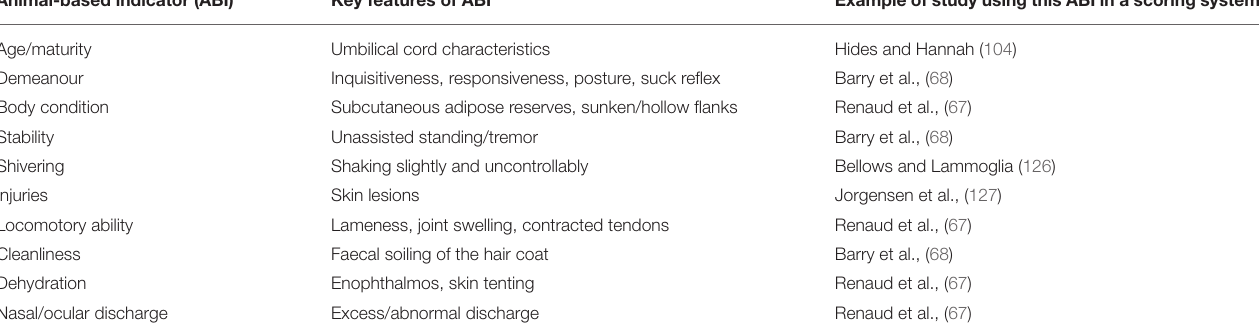
TABLE 3 | Examples of animal-based-indicators, their key features and published studies that used these indicators in a scoring system. Animal-based indicator (ABI)